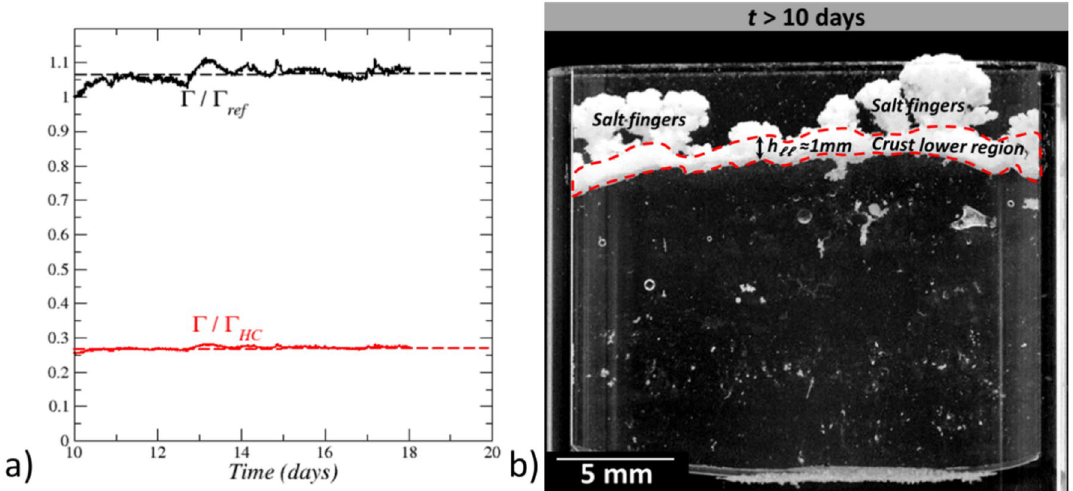
Figure 9. Salt crust diffusive conductance. ( a ) Salt crust diffusive conductance as a function of time in stage 4; Ŵ ref is the conductance at t = 10 days; Ŵ HC is the conductance in the Hele-Shaw cell free of crust; ( b ) Salt crust for t > 10 days with tentative separation between the salt finger region (crust upper region) and the salt crust lower region (region within the red dashed